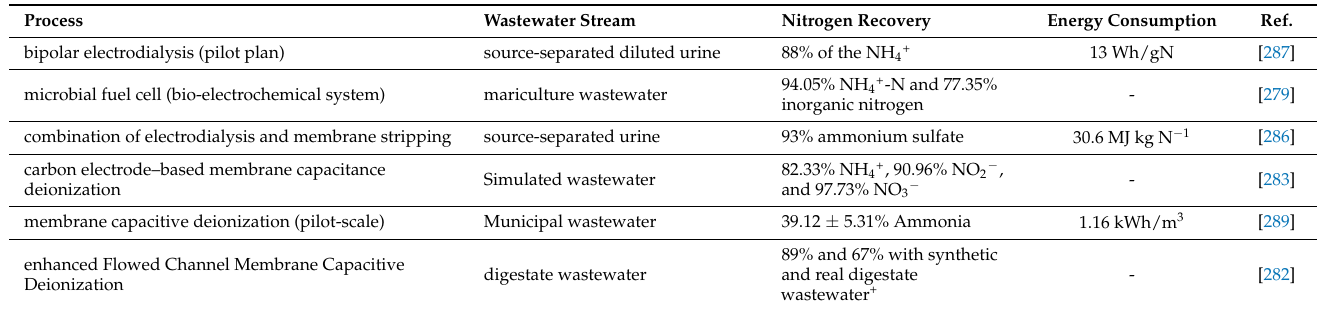
Table 7. Nitrogen recovery and energy requirements of